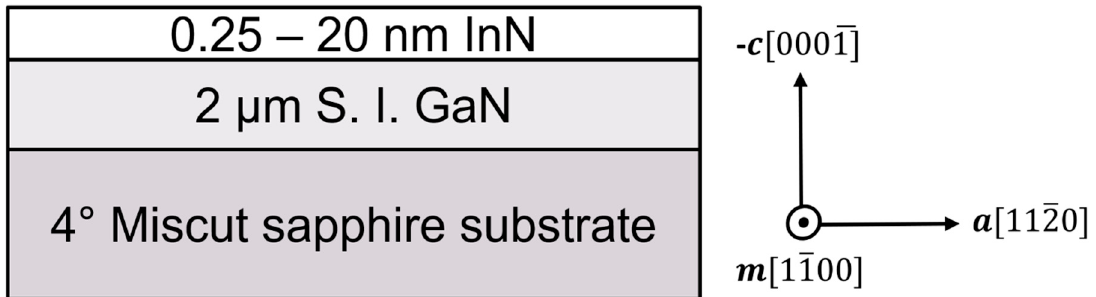
Figure 1. Epitaxial structure of uncapped N − polar InN samples.